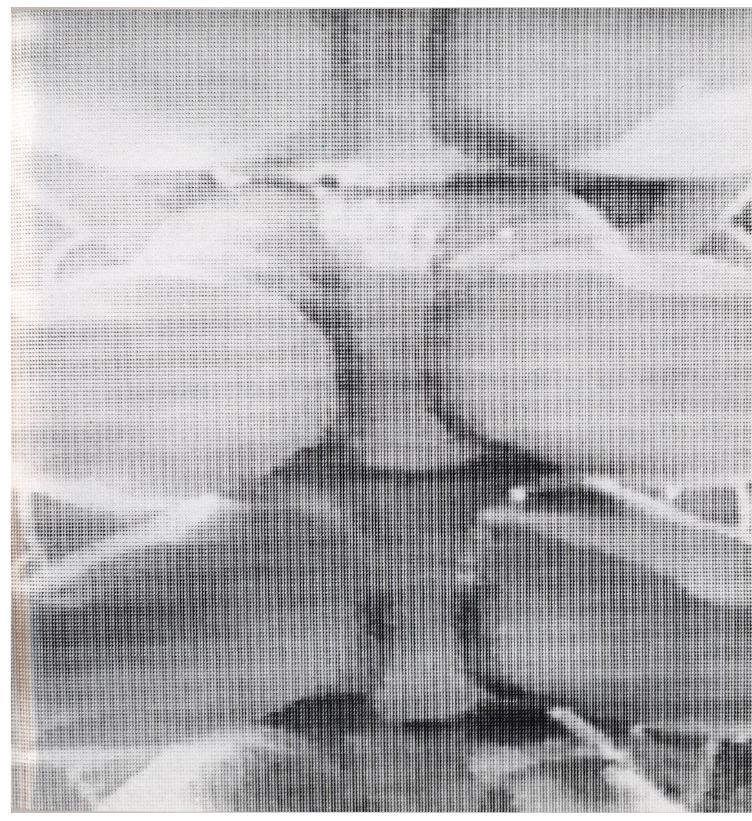
Figure 8. Kulik, guide, 1997. Crutch shots.